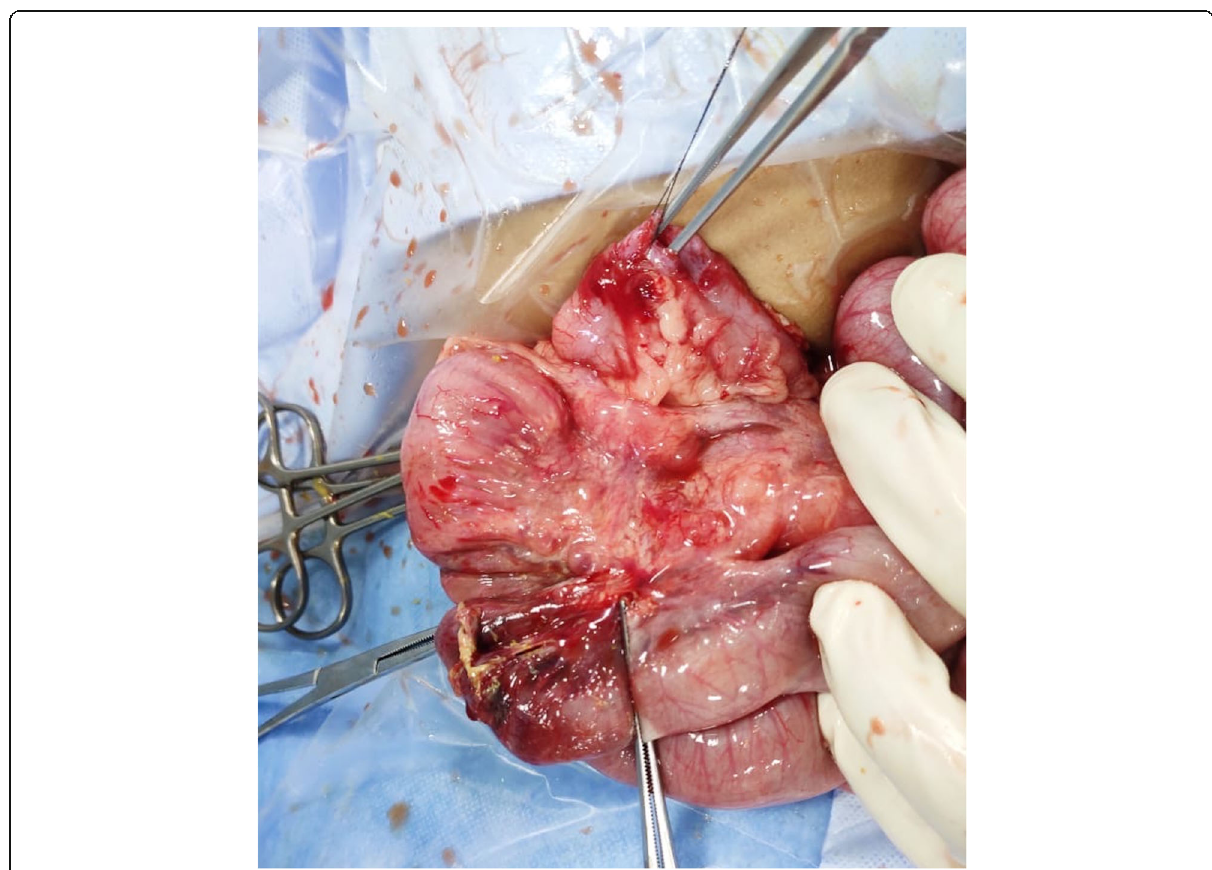
Fig. 3 Patient D with colonic perforation (marked with silk) and manually reduced necrotic intussusceptum